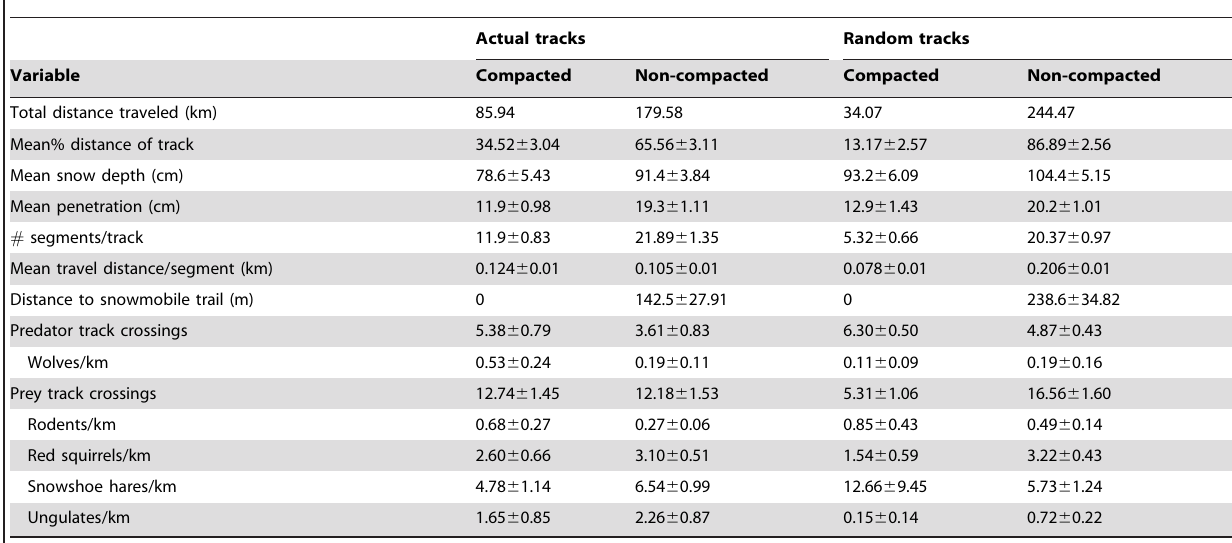
Table 1. Comparisons of variable means ( 6 SE) between compacted (used as a snowmobile trail) and non-compacted (undisturbed) track portions from actual (265.05 km) and random (278.54 km) coyote tracks recorded in the Togwotee Pass study area, northwestern Wyoming, 2006 –